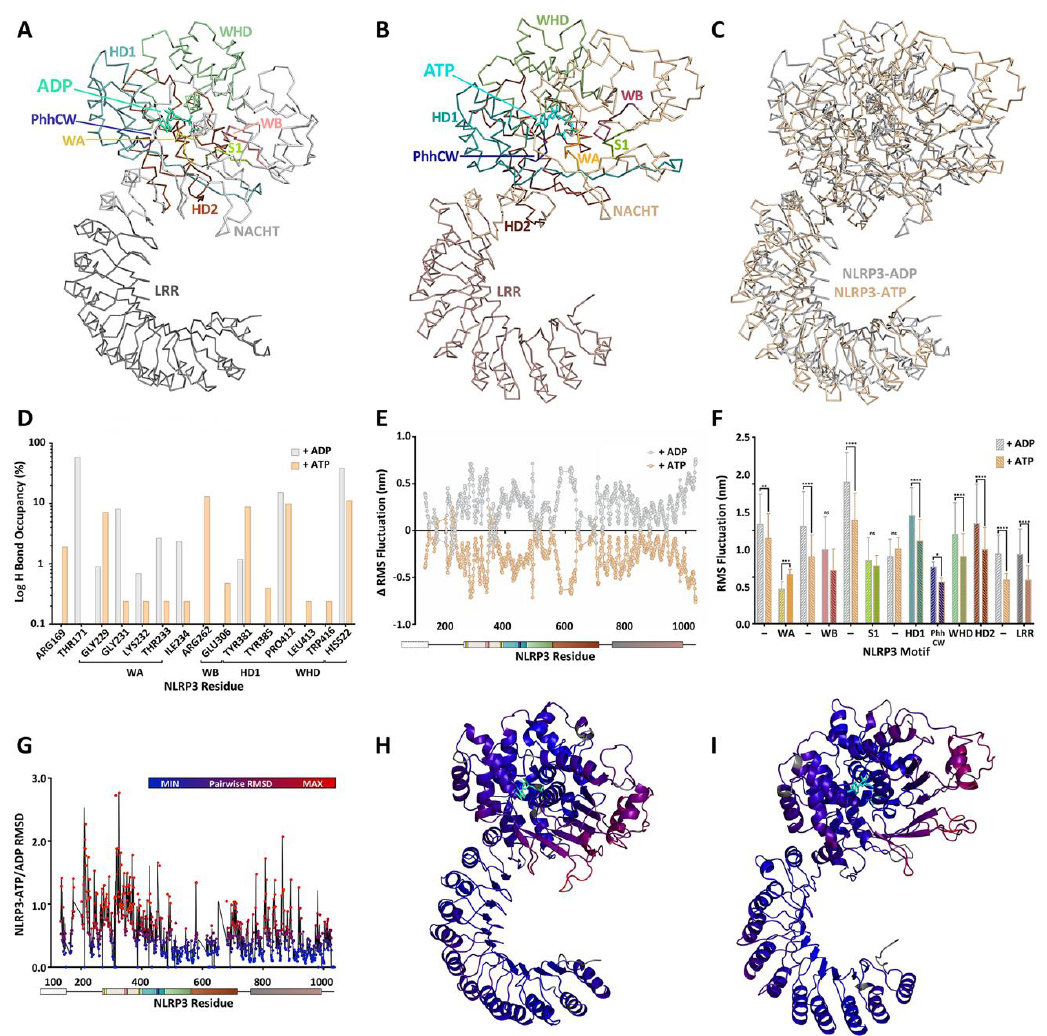
Figure 5. Binding of ATP or ADP ligands to NLRP3 suggests holistic structural differences. Backbone images are provided for the NLRP3-ADP ( A ) and NLRP3-ATP ( B ) structures. Important domains and motifs are colour-coded and labelled following visual rendering with PyMOL v2.4 (pymol.org), and the bound nucleotide ligand is shown in stick rendering. In ( C ), the backbone structures of NLRP3-ADP and NLRP3-ATP were aligned by sequence. ( D ) Hydrogen bond occupancy between NLRP3 and ADP or ATP observed over the course of 10 ns molecular simulation. The plot indicates how often hydrogen bonds between the nucleotides and the protein were observed during the simulation. ( E ) Root-mean-square (RMS) fluctuations of NLRP3 residue positions were calculated during the 10 ns molecular simulations with ADP or ATP. The average RMS fluctuations (nm) were plotted along the length of the NLRP3 primary sequence. Note: the PYD was not present in the NLRP3 protein construct used to generate the structure of the 6NPY deposition. ( F ) The average RMS fluctuations were calculated for each of the important NLRP3-NACHT motifs involved in nucleotide-binding and hydrolysis. The unstructured linker sequences connecting the domains/motifs are indicated by (—). Significantly different between ADP-and ATP-bound forms of NLRP3-NACHT: *, p<0.05, **, p<0.01, ***, p< 0.001, and ****, P<0.0001; two-way ANOVA with Holm-Sidak post hoc test. In ( G ), the NLRP3- ATP and NLRP3-ADP structures were compared across the 10 ns molecular simulations, and RMSD values were calculated for all the NLRP3 residues and plotted along the length of the NLRP3 primary sequence. The RMSD values were used to colour the NLRP3-ADP ( H ) and NLRP3-ATP ( I ) ribbon diagrams. The structures are coloured with heat-mapping, where blue to red, where red designates